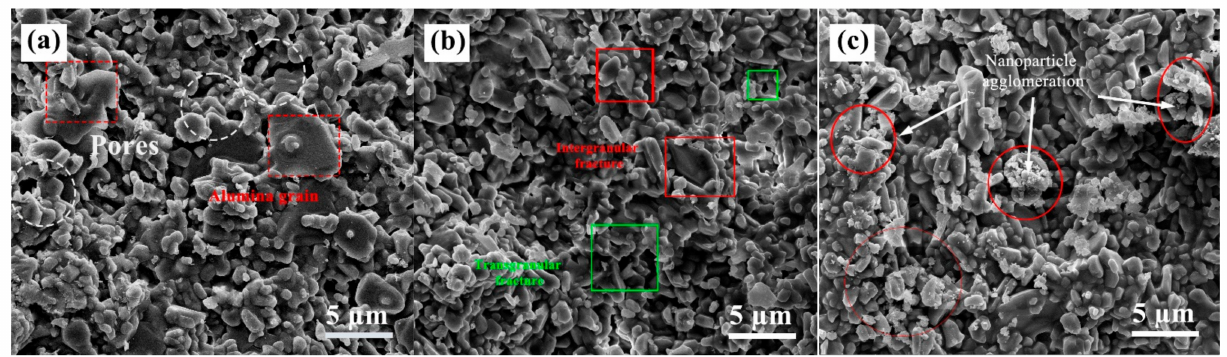
Figure 9. SEM images of sintered ceramics prepared with different SiC contents. ( a ) 0 wt%; ( b ) 8 wt%; ( c ) 10 wt%.